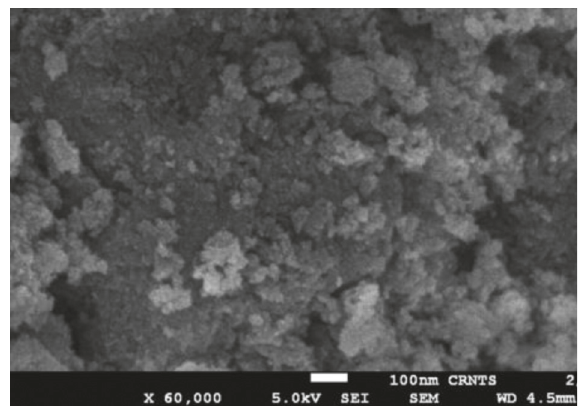
Figure 2: Scan electronic microscope image of Nickel Zinc Iron Oxide